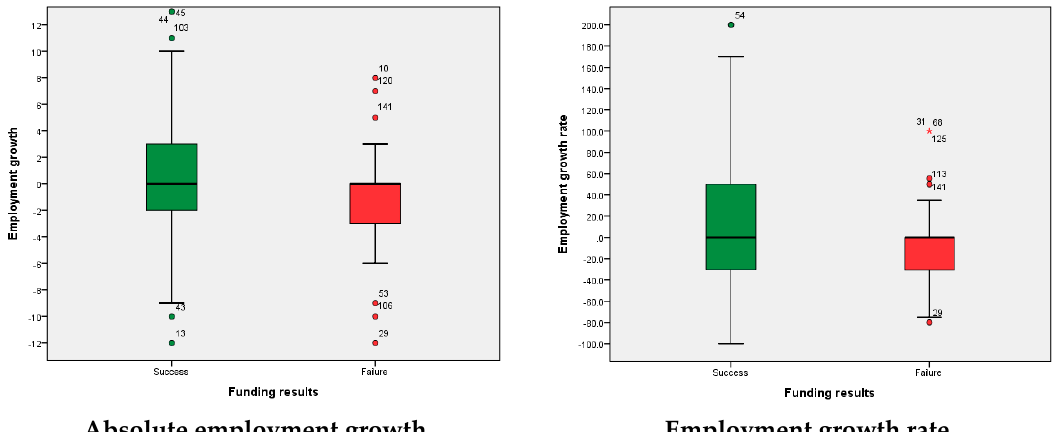
Figure 3. Boxplots of comparing employment outcomes.